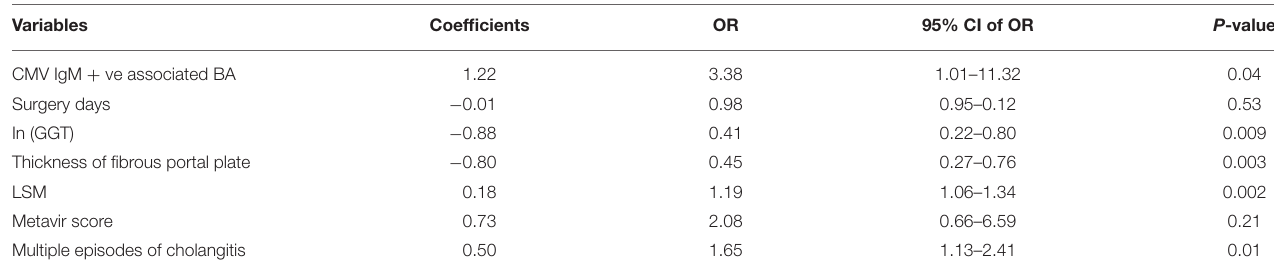
TABLE 3 | Multivariate logistic regression analysis to construct nomogram in training